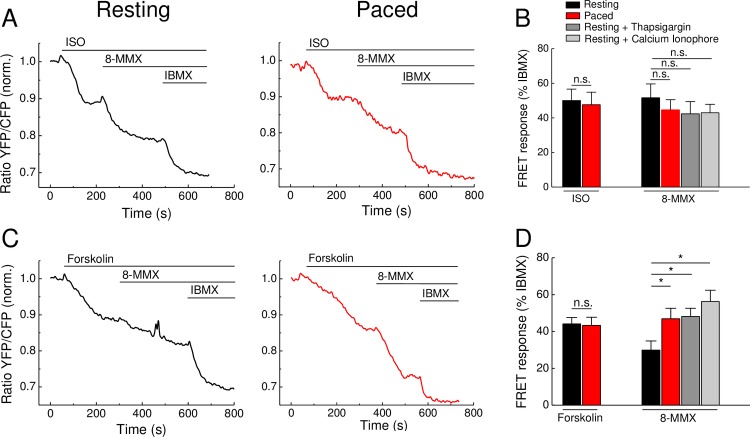
cAMP dynamics in adult mouse cardiomyocytes upon treatment with cAMP elevating agents and PDE1 inhibition.(A) Representative FRET traces of Epac1-camps cardiomyocytes stimulated with the β-AR agonist isoproterenol (ISO, 100 nM) or with the direct AC activator forskolin (10 μM) (C). Subsequent application of the PDE1 inhibitor 8-methoxymethyl-3-isobutyl-1-methylxanthine (8-MMX, 30 μM) enhances the cAMP stimulatory effect of ISO and forskolin. Stimulation with the unselective PDE inhibitor 3-isobutyl-1-methylxanthin (IBMX, 100 μM) leads to a further increase of cAMP. (B and D) Quantification of experiments shows no significant difference in FRET responses between control and paced cardiomyocytes stimulated with ISO. Forskolin stimulated cardiomyocytes show significant differences in PDE1 contribution to total PDE inhibition which is significantly higher in paced cardiomyocytes as compared to resting cells. Pretreatment of resting cardiomyocytes with calcium elevating reagents such as thapsigargin (100 nM) and calcium ionophore A23187 (10 μM) mimics the effect of field stimulation. Cells were paced at 1 Hz. Values are means ± SEM; n = 6–10 cells isolated from 3 hearts per condition; *—significant difference at p<0.05 by one-way ANOVA; n.s.- not significant.